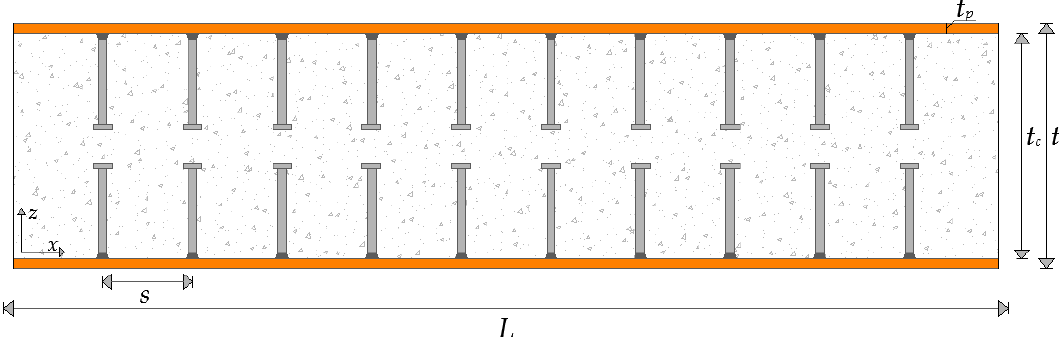
Figure 2. Cross-section of a double-steel plate concrete wall with partially confined concrete.